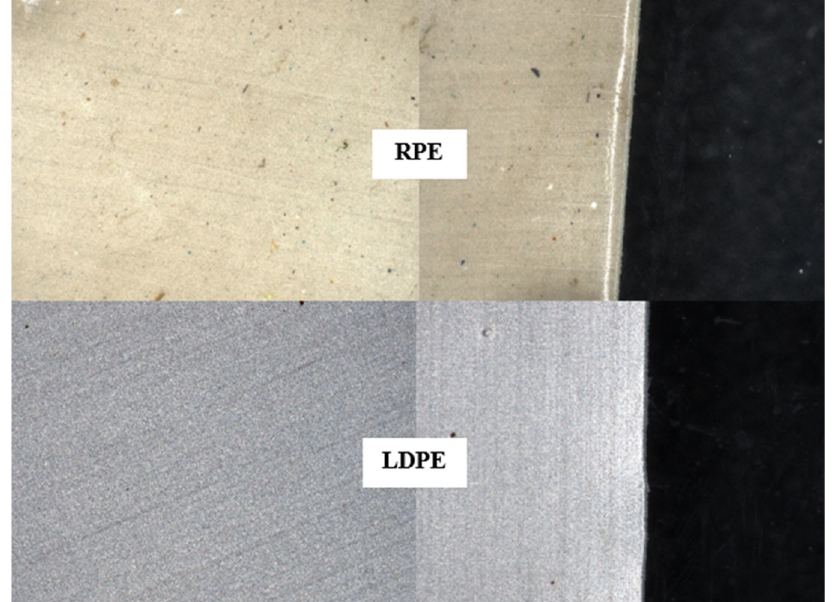
Figure 12. RPE and LDPE sheets on aluminum foil at 100× magnification, pressed at 130 °C (LDPE) and 200 °C (RPE) at 100 kN for 15 min (2.5 min warmup at 0 kN, 12.5 min at 100 kN). The edges of the films are shown on the left and in the center of the films on the right.